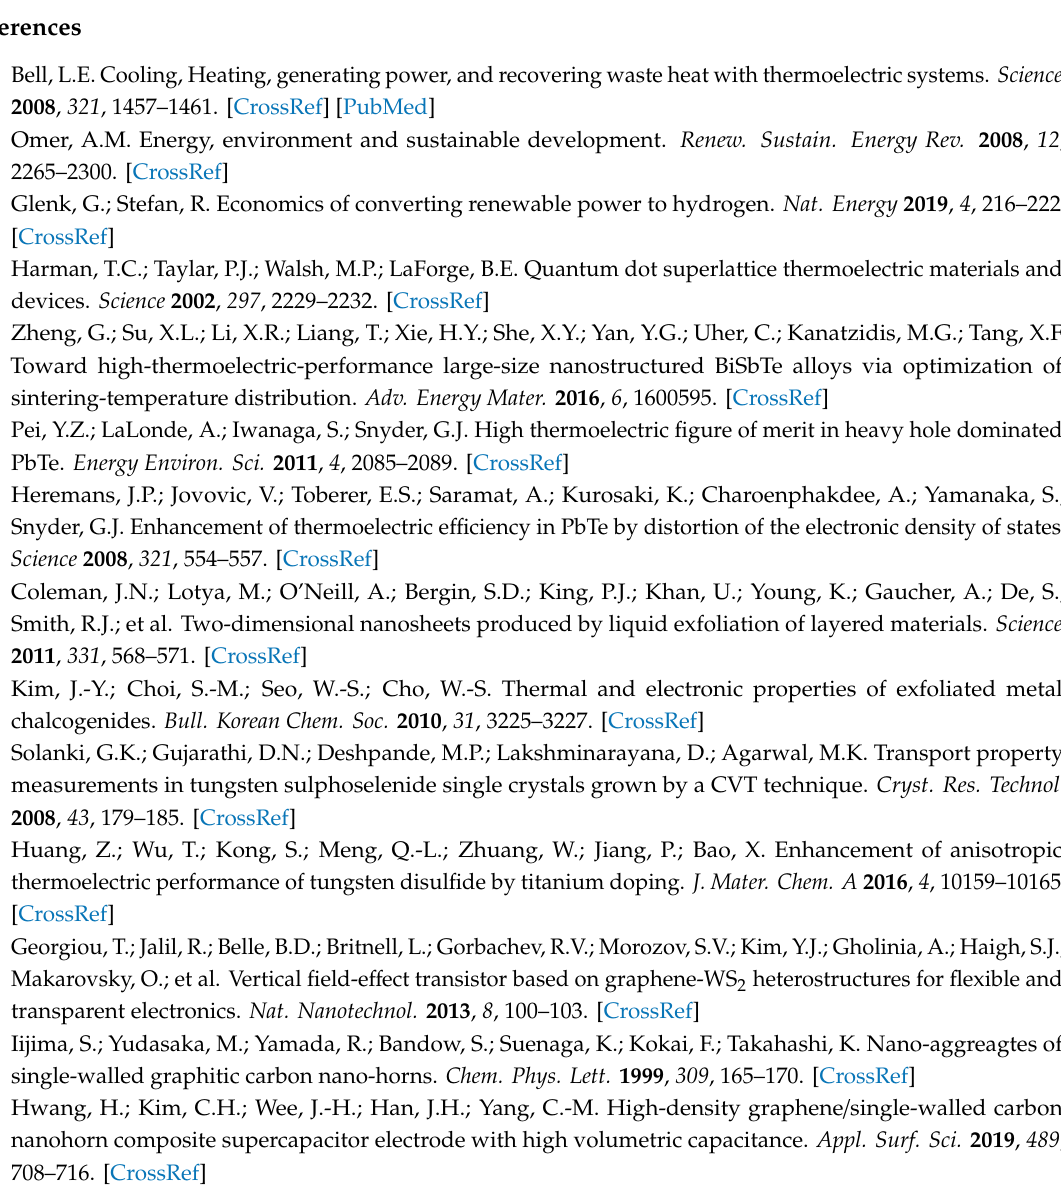
Figure S1: Sintering profiles and mass densities of the sintered WS 2 and WS 2 / SWCNH nanocomposites. Figure S2: FE-SEM-EDX of the sintered WS 2 and WS 2 / SWCNH nanocomposites. Figure S3: Raman spectrum of the SWCNH powder. Table S1: Raman factors of the SWCNH powder. Table S2: Raman factors of the sintered WS 2 and WS 2 / SWCNH nanocomposites. Figure S4: Thermoelectric characteristics of the sintered WS 2 and WS 2 / SWCNH